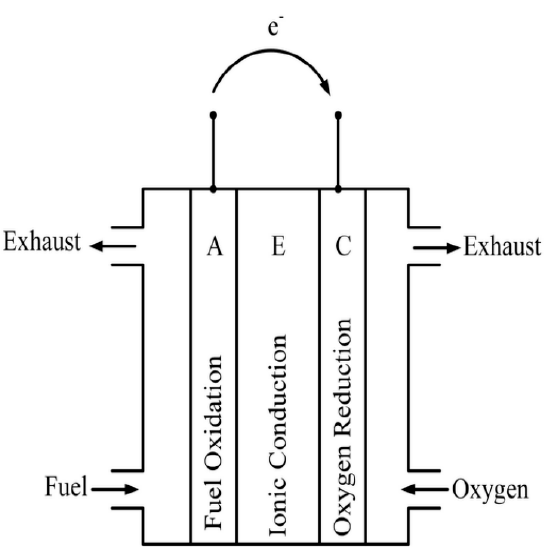
Figure 31. Working principle of fuel cell. Fuel and oxygen is taken in, exhaust and current is generated as the products of chemical reaction. Adapted from [4].